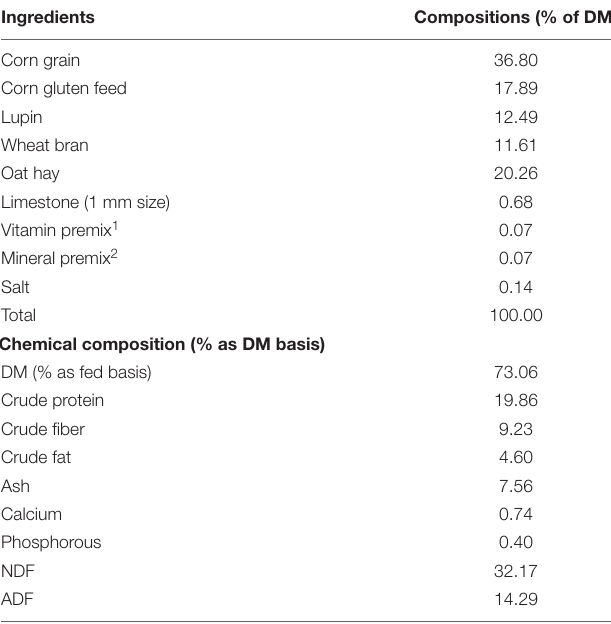
TABLE 1 | Ingredients and chemical composition of the TMR fed to the steers.